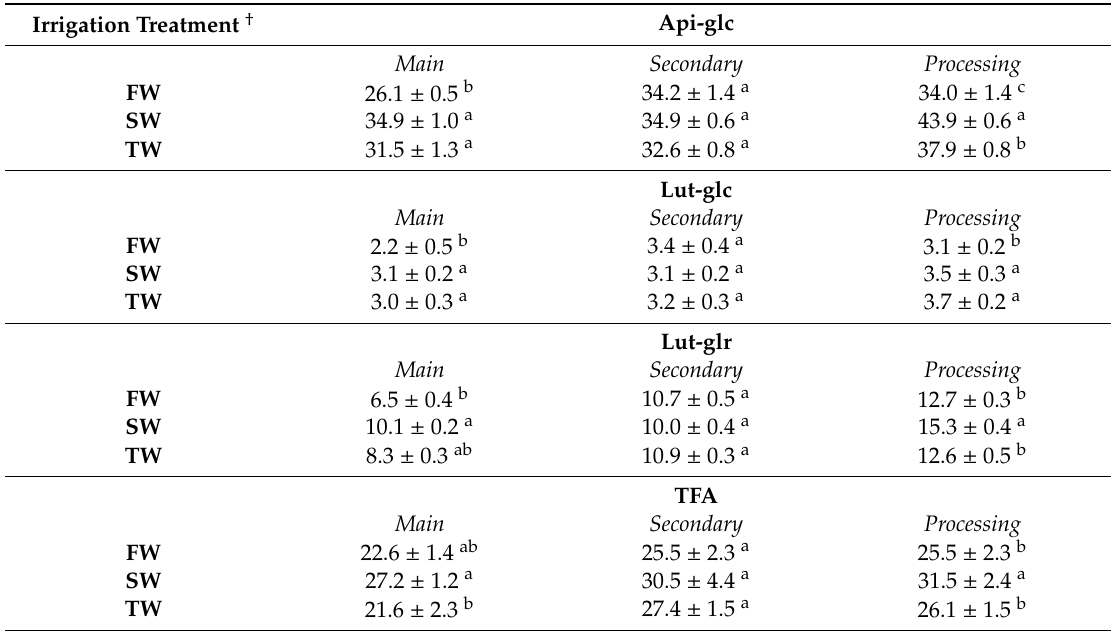
Table 4. E ff ects of the main experimental factors (growing season and irrigation treatment) on apigenin and luteolin components and their conjugates, and trans-ferulic acid content (mg 100 g − 1 d.w.) of main, secondary, and processing artichoke